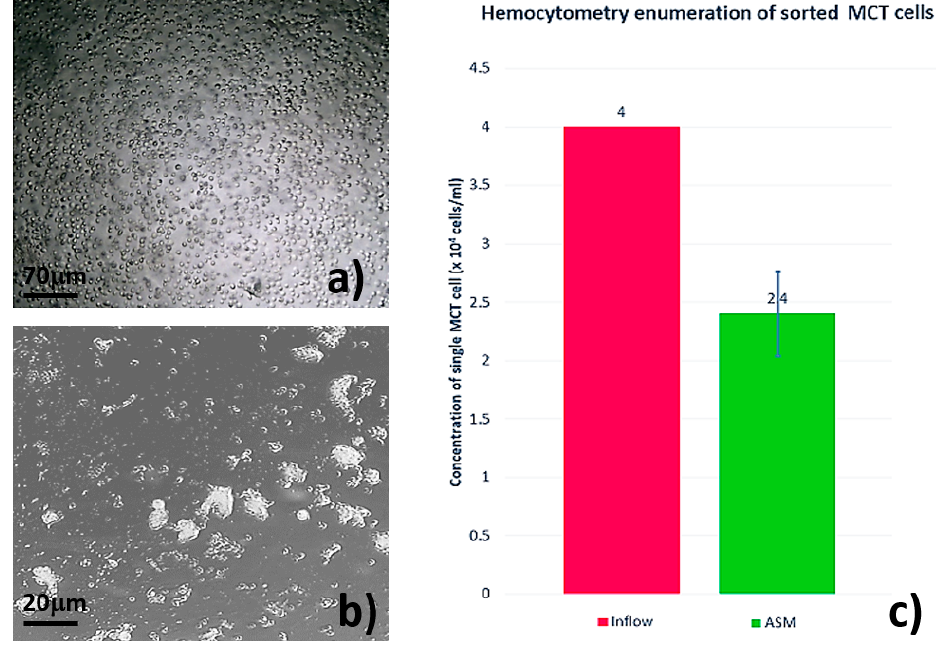
Figure 5. The aftermath of hydrodynamic shear stresses on the cell viability of the sorted MCT cells. ( a ) The morphology of MCT cells before sorting indicated that unsorted MCT cells were round and discrete. The concentration of viable MCT cells was plentiful. ( b ) The micrograph exhibits cellular attrition in the system. The sorted MCT cells were deformed or necrotized. Notably, their morphological features were changed, for example elongation and severe swelling. Cellular destruction and the protrusion of cytoplasmic granules were commonly seen in the field. ( c ) Likewise, the cellular enumeration with the hemocytometer overtly confirmed a reduction of viably sorted MCT cells, in which the cellular concentration after sorting was down to 2.4 × 10 4 cells/mL (green bar).